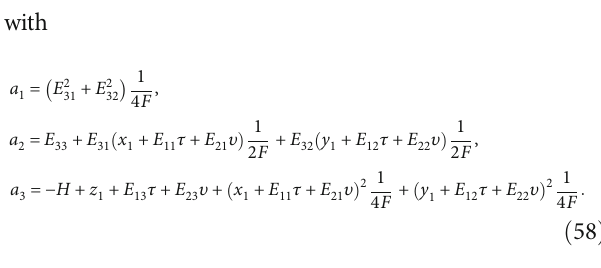
Line normal to the facet Figure 13: Two intersections between the line normal to the facet plane and the desired parabolic working